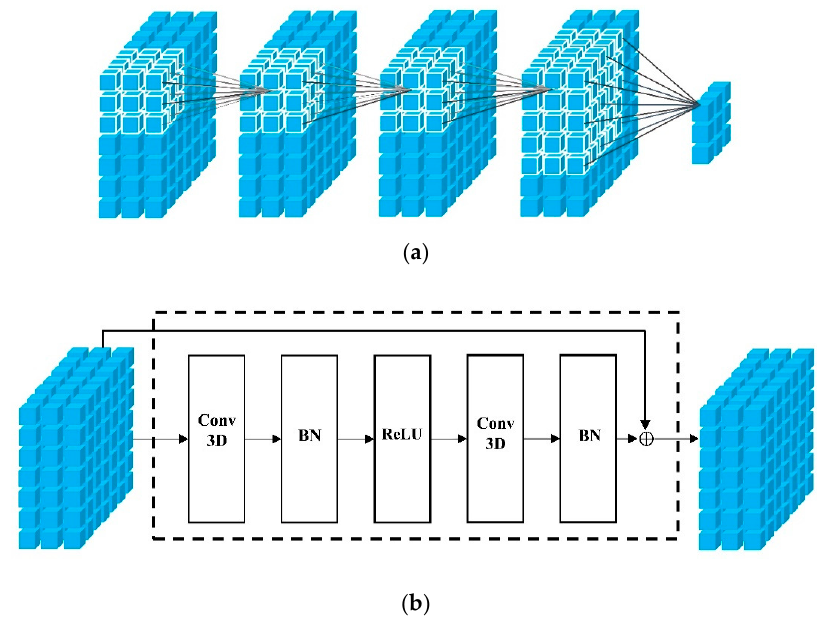
Figure 4 . 3D convolution and 3D Residual Unit: ( a ) 3D convolution; ( b ) 3D Residual Unit Figure 4. 3D convolution and 3D Residual Unit: ( a ) 3D convolution; ( b ) 3D Residual